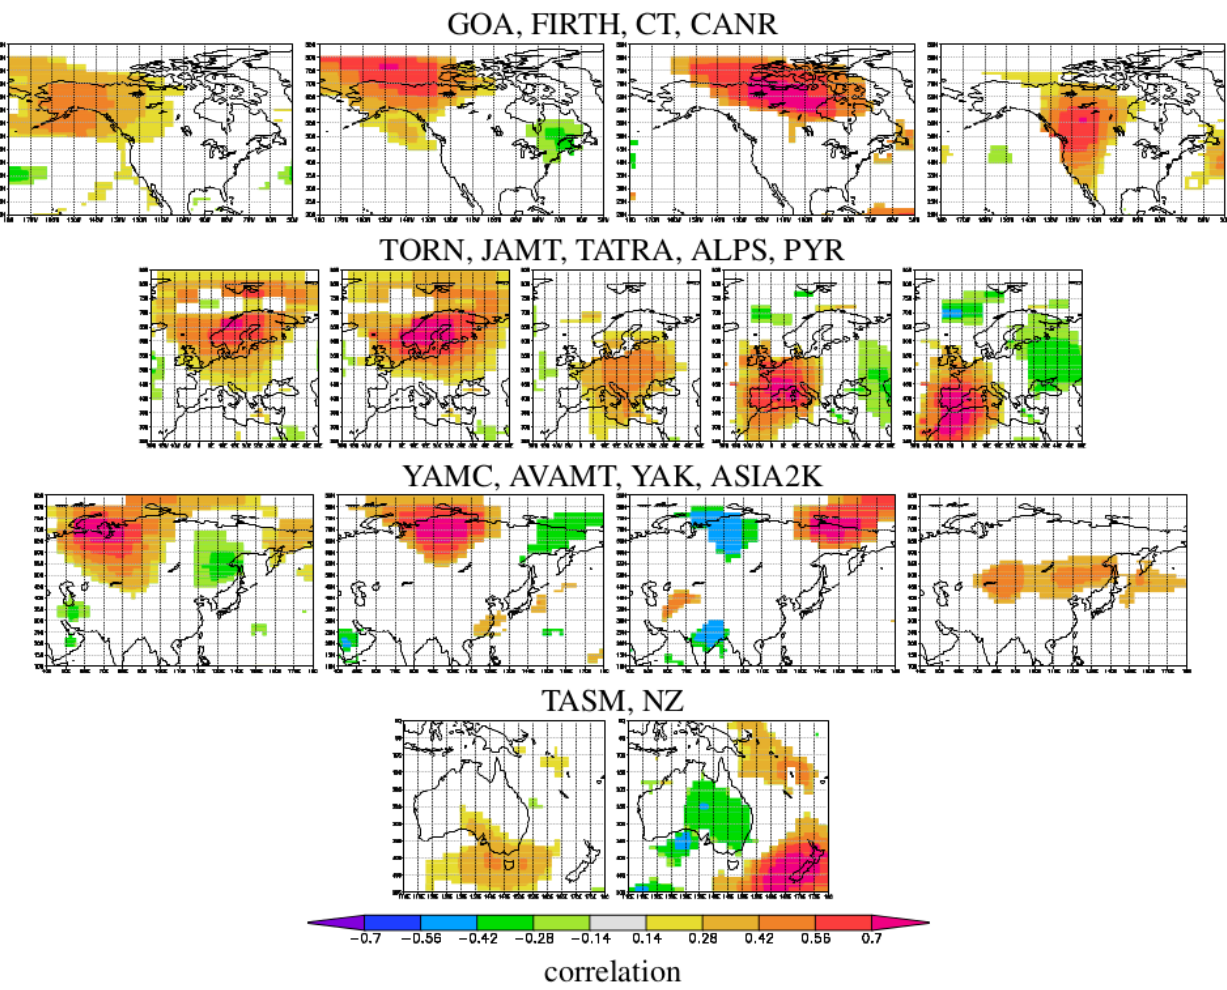
Figure 1. Correlation between each tree-ring chronology and the GISS1200 instrumental temperature field, based on first-differenced data for seasonal averages and time periods as used for calibration by each original investigator (see Tables 1 and 3). Colours are muted where correla- tions are not significant at the 5% level. Analysis made on the KNMI Climate Explorer (http://climexp.knmi.nl, Trouet and van Oldenborgh,